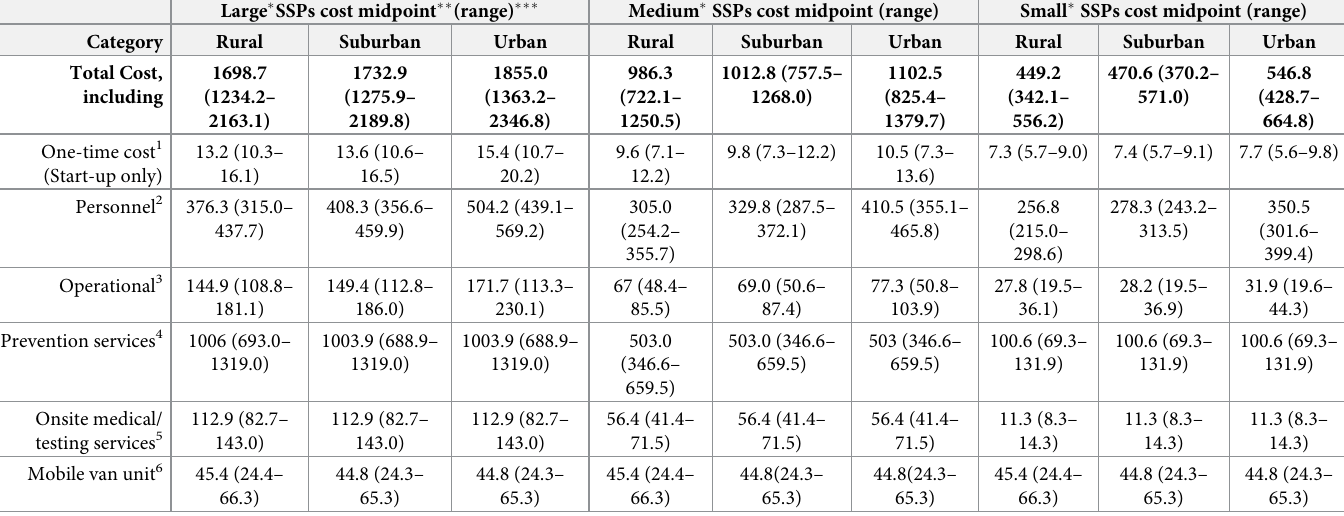
Table 1. Estimated costs of a comprehensive syringe service program (SSP) by size and geographic location, United States (in $1,000 2016 US